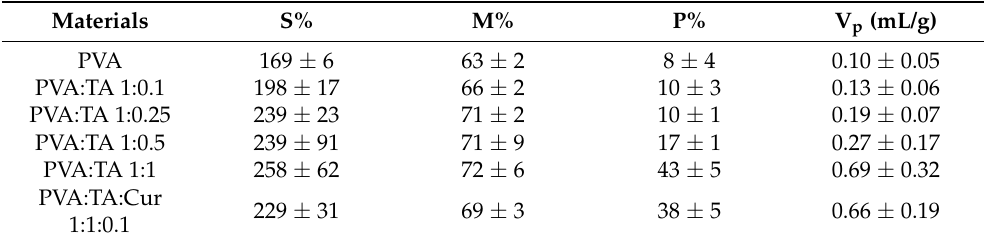
Table 1. Swelling rate (S%), moisture content (M%), porosity (P%), and total pore volume (V p ) of